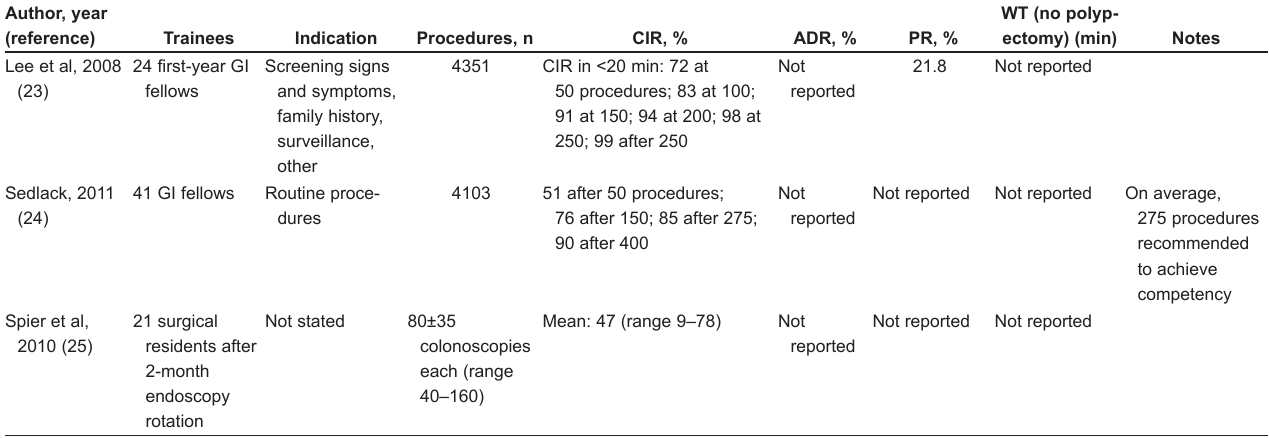
TAble 2 Study outcomes, training and